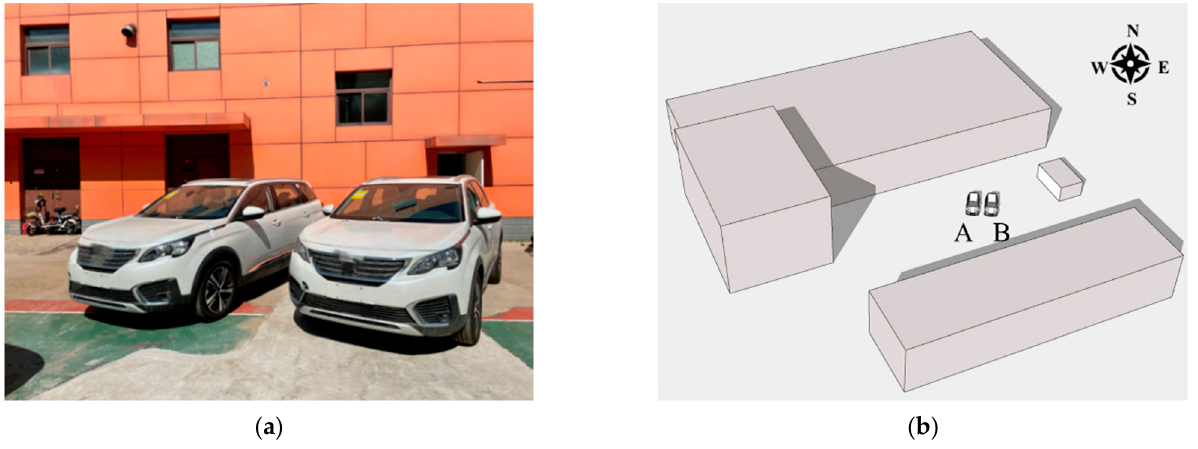
Figure 2. Measurement object and site: ( a ) two identical vehicles; ( b ) vehicles’ orientation and surrounding buildings in the site during the measurements.